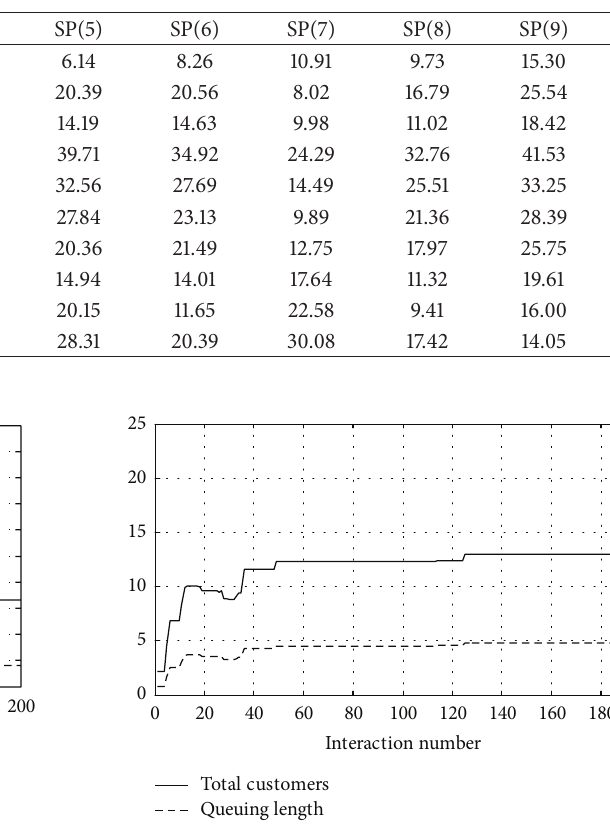
Figure 6: Optimization of total transportation time and total sojourn time.